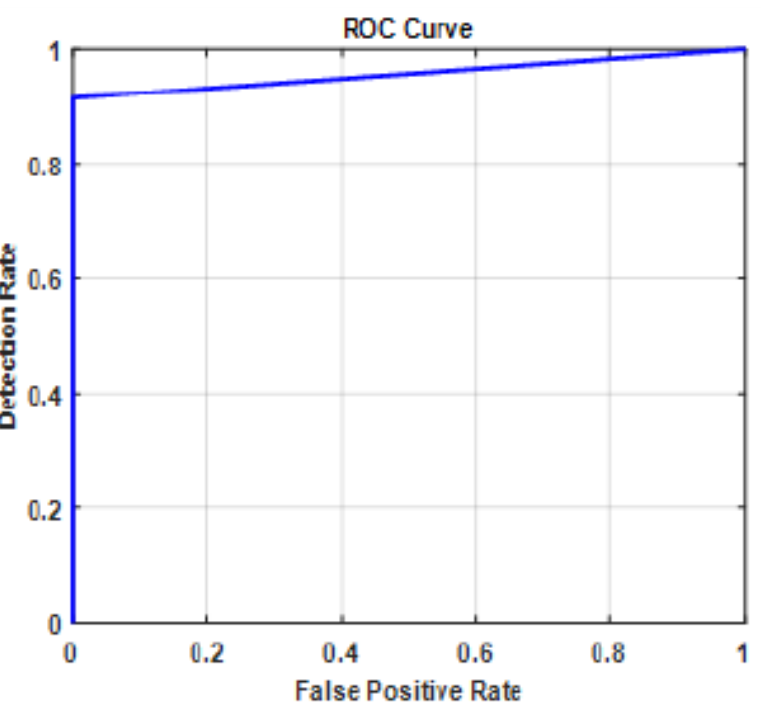
Figure 8. ROC curve for InceptionResNetv2-MCSVM-based model with image SR using dataset #1.